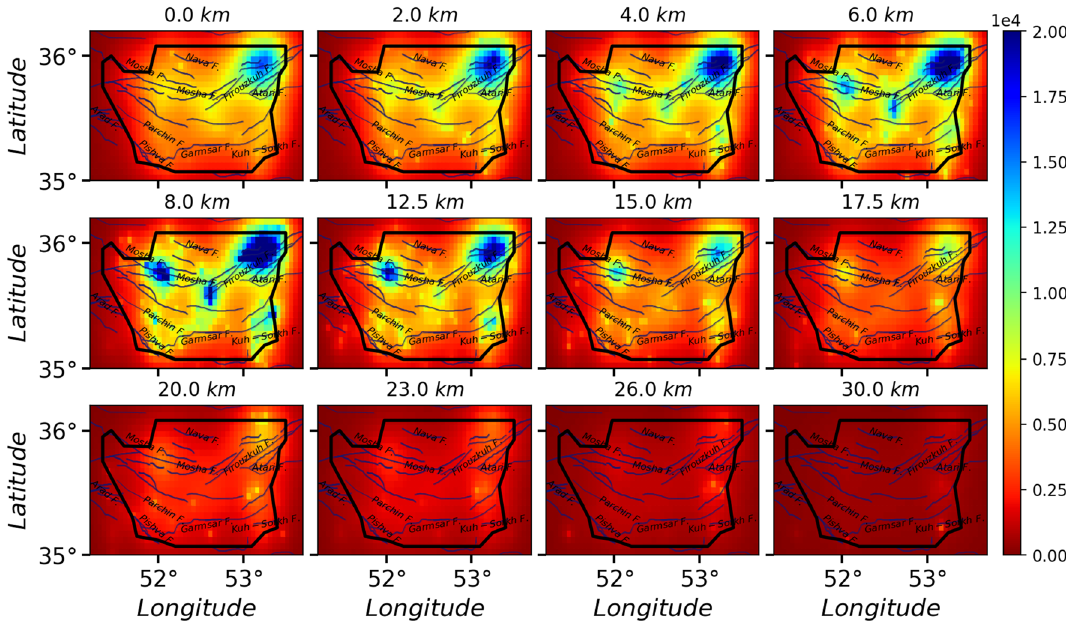
Figure 7. The activity Field for 1000000 avalanches in the whole space, wherein each avalanche starts from an event M ≥ 2.5 site. The solid lines and black border indicate the known faults and the region with good resolution,